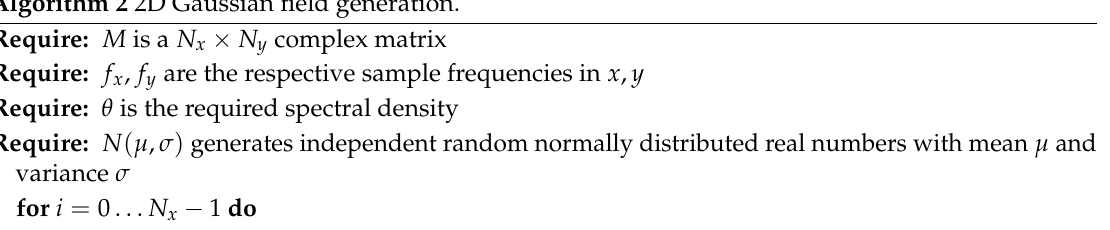
Algorithm 2 2D Gaussian field